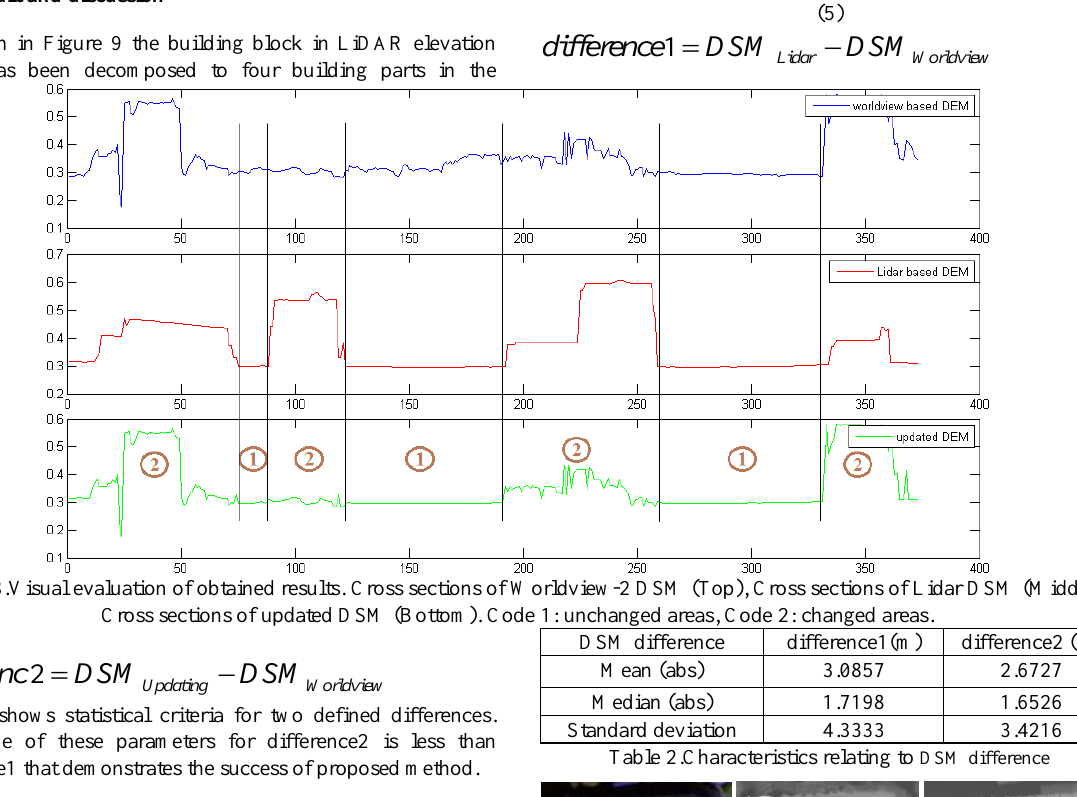
Table 2.Characteristics relating to DSM difference